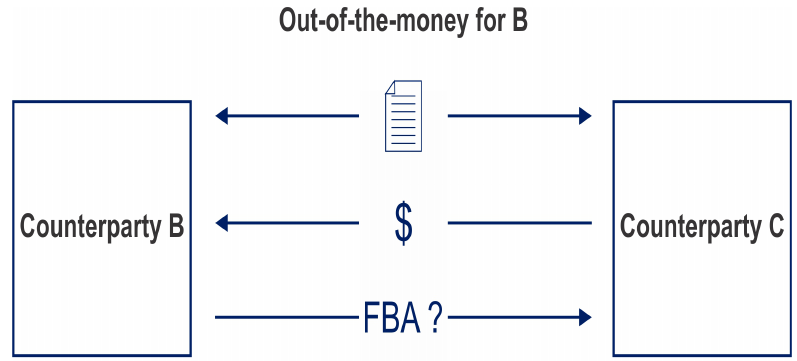
Illustrating a trade graphically between Counterparties B and C when Counterparty B is out-of-the-money.